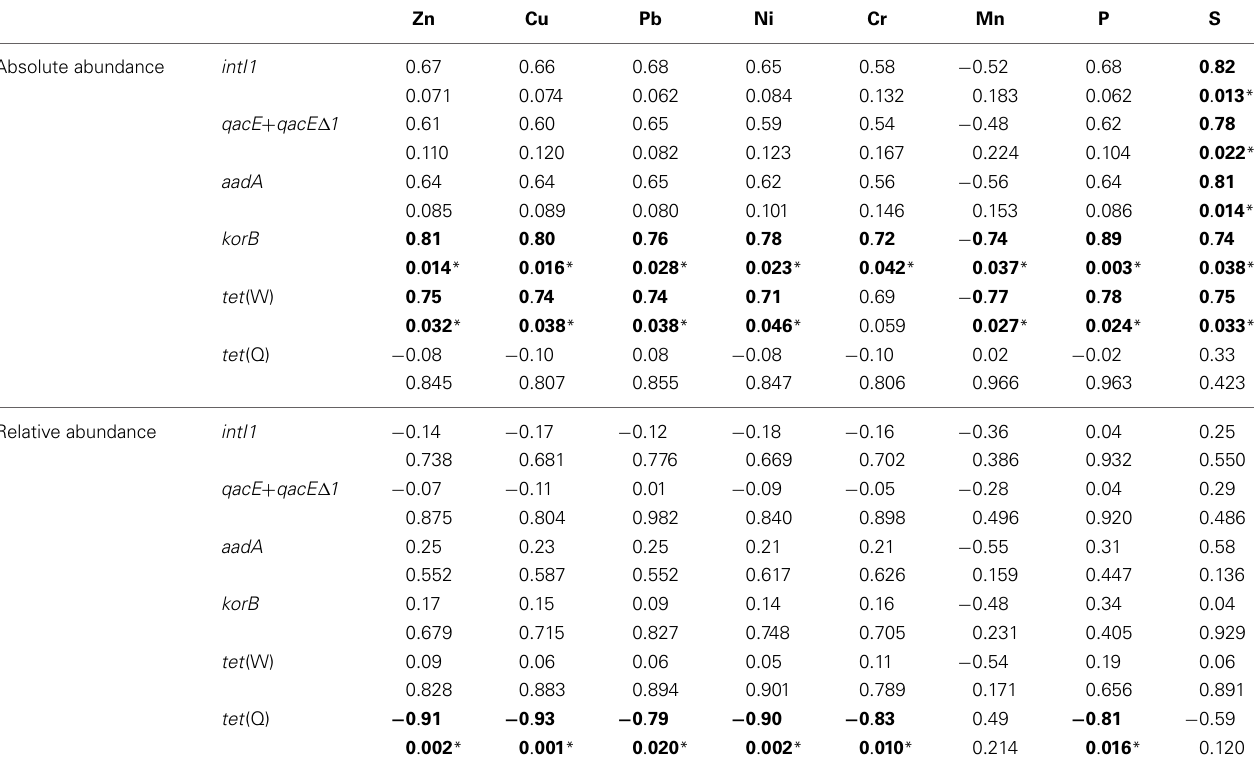
Table 3 | Correlation of absolute (log(gene copies/g soil)) and relative abundance (log(gene copies/ rrn copies)) of target genes with concentrations of heavy metals, S, and P (1.5–100 years of irrigation; Pearson correlation, p < 0 . 05; significance indicated in bold and by